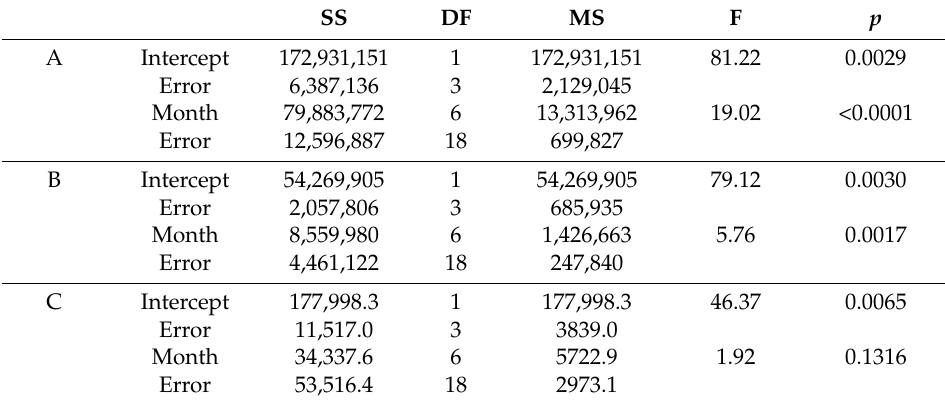
Table 1. Repeated measures ANOVA of A: bacterial fouling pressure (measured as bacterial density on glass slides; see Figure 1A); B: bacterial density on Z. marina (see Figure 1B); C: bacterial density on Z. marina relative to bacterial fouling pressure (see Figure 1C) in different months.